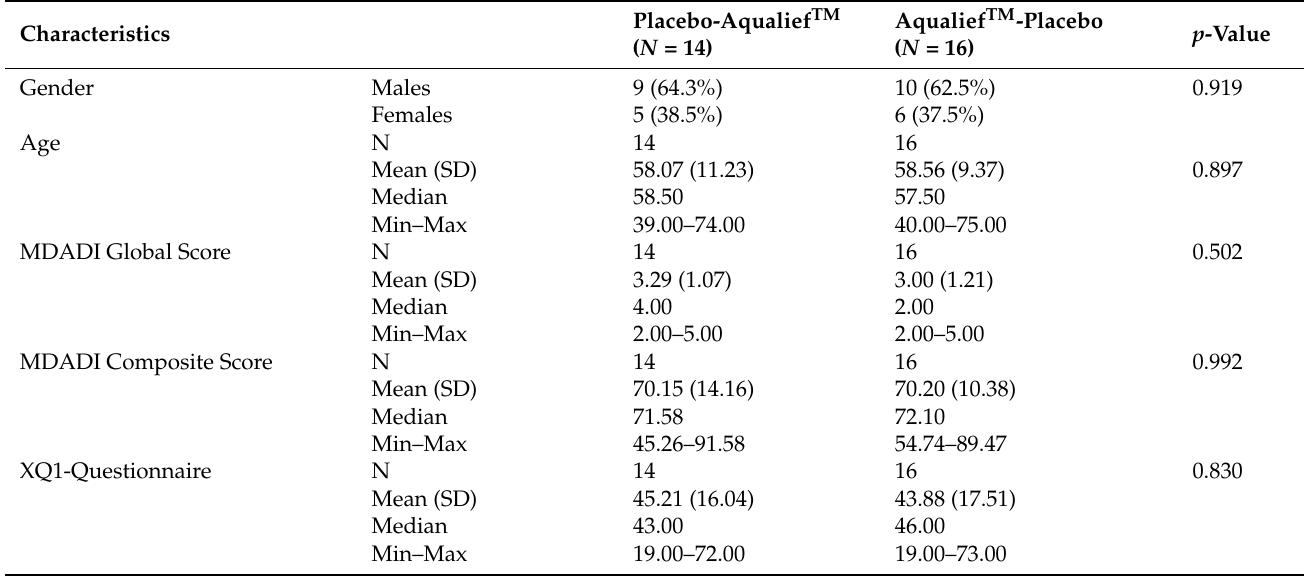
Table 1. Demographics and Treatment Details of the Safety Population.